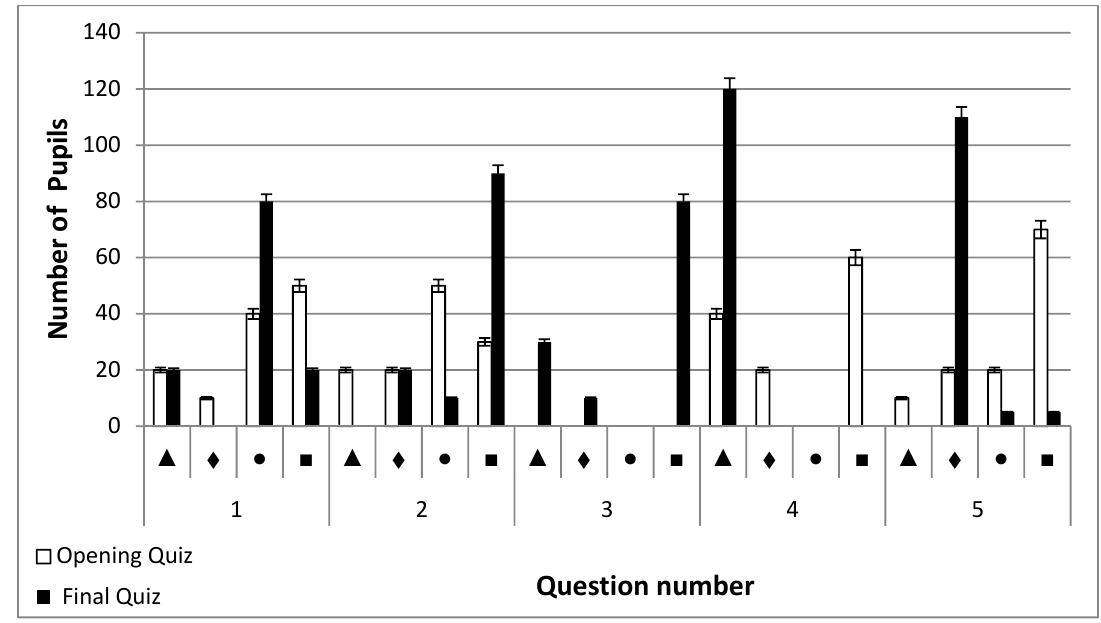
Figure 5. The distribution of the responses in the opening and the final questionnaires.